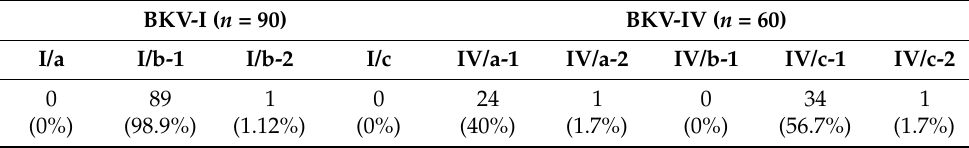
Table 6. Distribution of BKV Table 6 . Distribution of BKV subgroups .